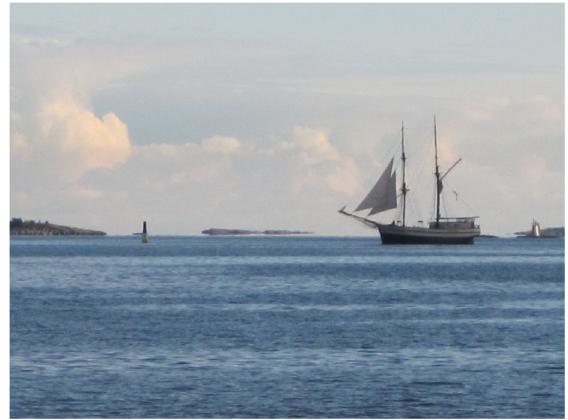
Fig. 1 The fi ve Nordic Nations, Norden , have not engaged in war with one another since 1815. A dispute between Finland and Sweden over the strategically located Åland Islands was resolved through mediation. The Åland Islands remain a demilitarised and neutral area. Reproduced with permission of Douglas P. Fry; copyright © Douglas P. Fry, all rights